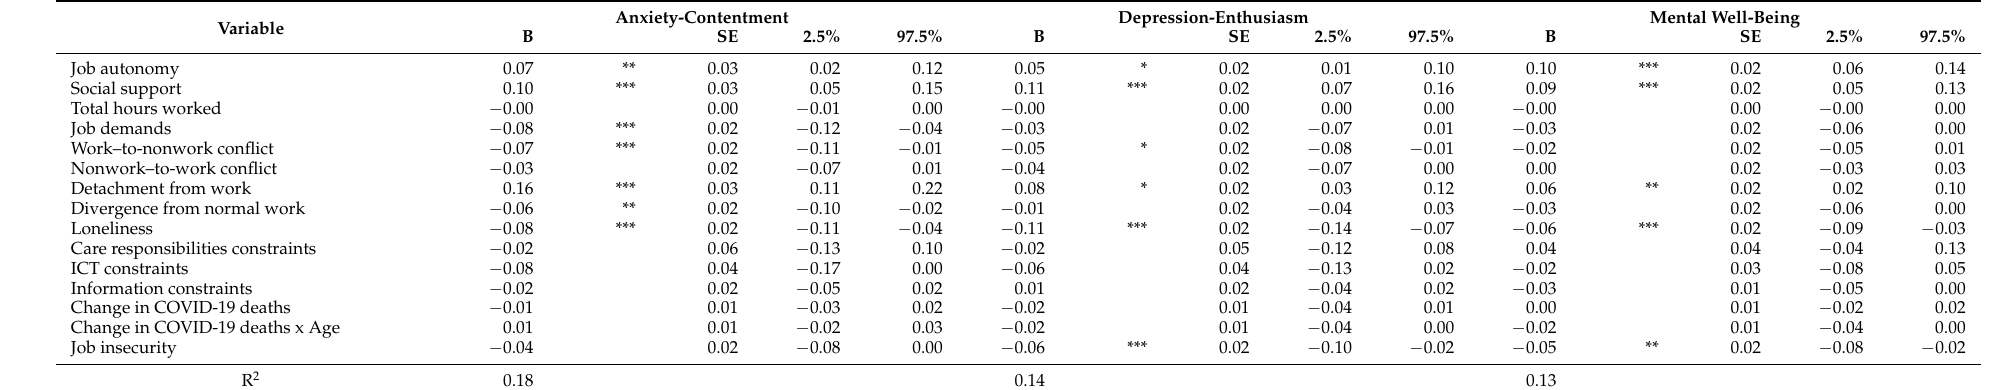
Table 5. Phase 2 within-person effects on